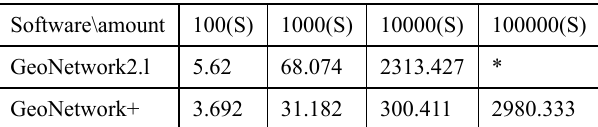
Table 2 upload efficiency contrast on different amount of